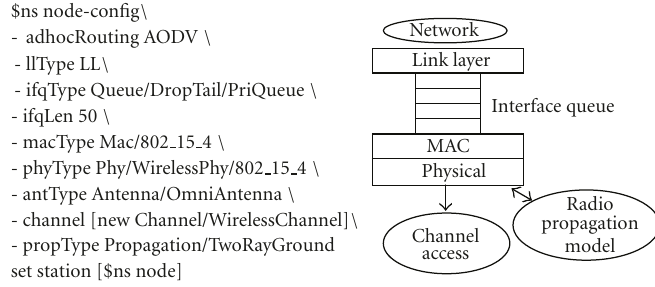
Figure 4: An example for the configuration of a wireless sensor node compliant to the IEEE 802.15.4 standard. The parameters of the NS-2 API (in TCL scripting language) follow the color scheme of the figure on the right: in Orange the Radio Propagation Model, Channel, and Antenna specifications, in Blue the Physical layer, in Green the MAC layer, in Purple the ifQ type and dimensioning, in Red the Routing